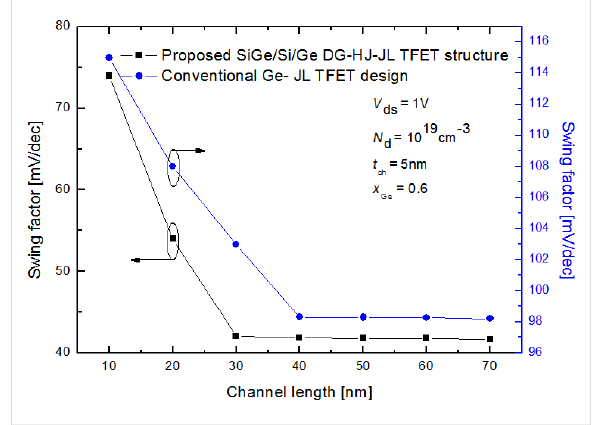
Figure 5: Subthreshold swing factor as a function of the channel length for both the proposed Si 1 − x Ge x /Si/Ge DG-HJ-JL TFET and the conventional Ge-DG-JL TFET with N d = 1·10 19 cm − 3 , V ds = 1 V, t ox = 2 nm, L s = 10 nm and t ch =